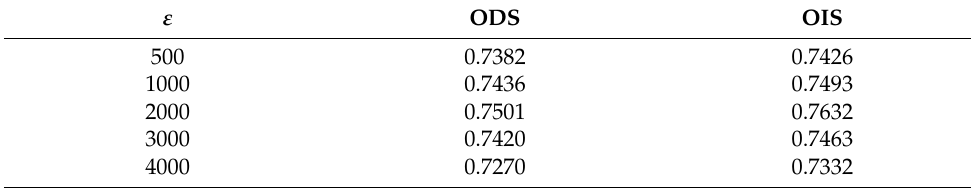
Table 7. Effect of balance factor on the edge detection performance on the